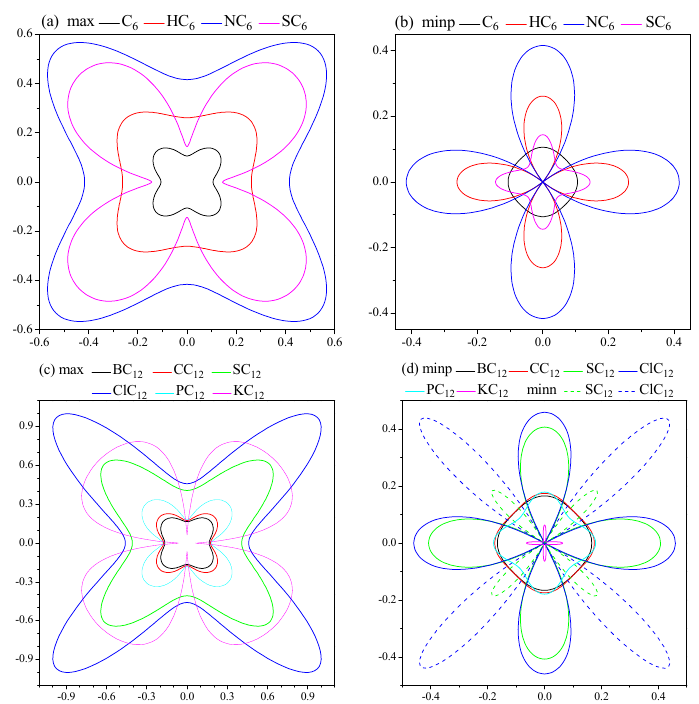
Figure 5. 2D representations of Poisson’s ratio. ( a ) Maximum of C 6 and XC 6 stable phases; ( b ) minimum positive of C 6 and XC 6 stable phases; ( c ) maximum of XC 12 stable phases; and ( d ) minimum positive and minimum negative of XC 12 stable phases; particularly, only SC 12 and ClC 12 have the negative minimum Poisson’s ratio, the solid and dash lines represent the minimum positive and minimal negative, respectively.